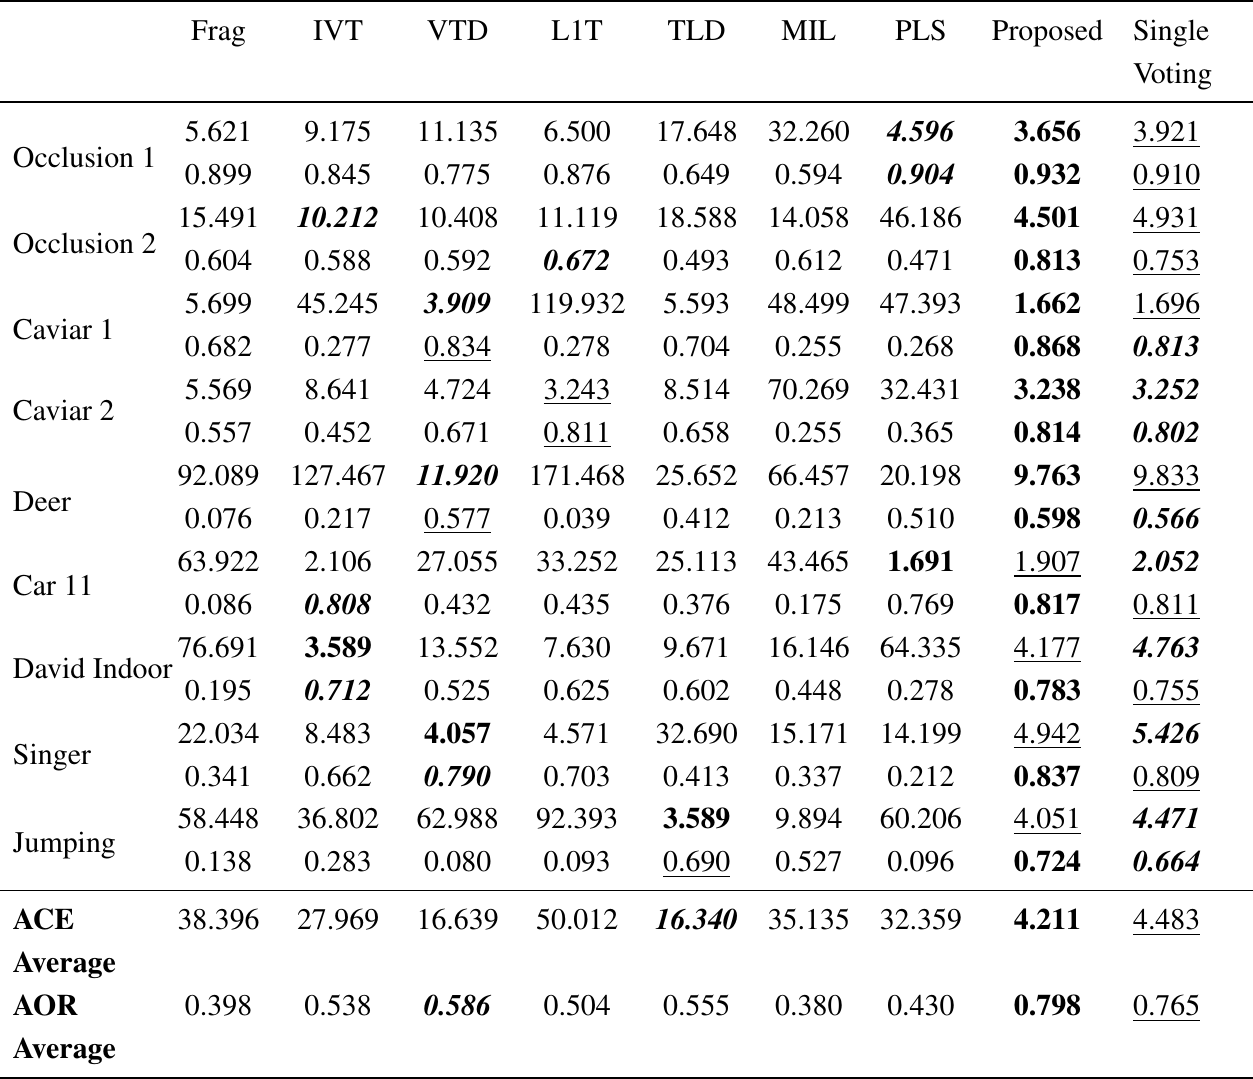
Table 1. Center error (pixels) and overlap rate of the tracking methods. The best three results are in bold, italicized and underlined